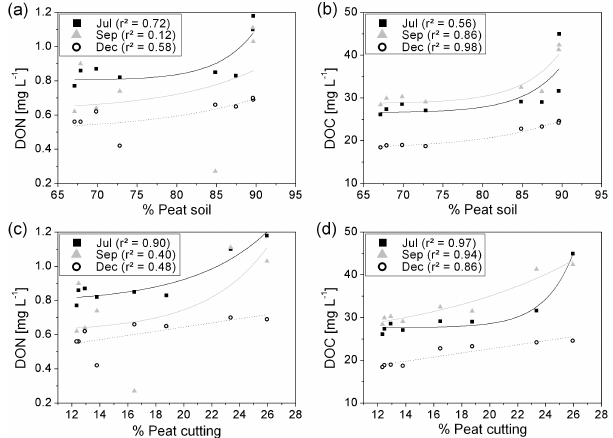
Fig. 7. Relationships between % area of peat soil (a) , (b) and peat cutting (c) , (d) in eight subcatchments of the Moorland catchment and spatial concentrations of DON (a) , (c) and DOC (b) , (d) at sub- catchment outlets. The results are shown for July (black squares and line), September (grey triangles and line) and December (black circles and dotted line) and fitted as y = A · exp( x/t ) + y 0). Coeffi- cients of determinations ( r 2 ) are given for each